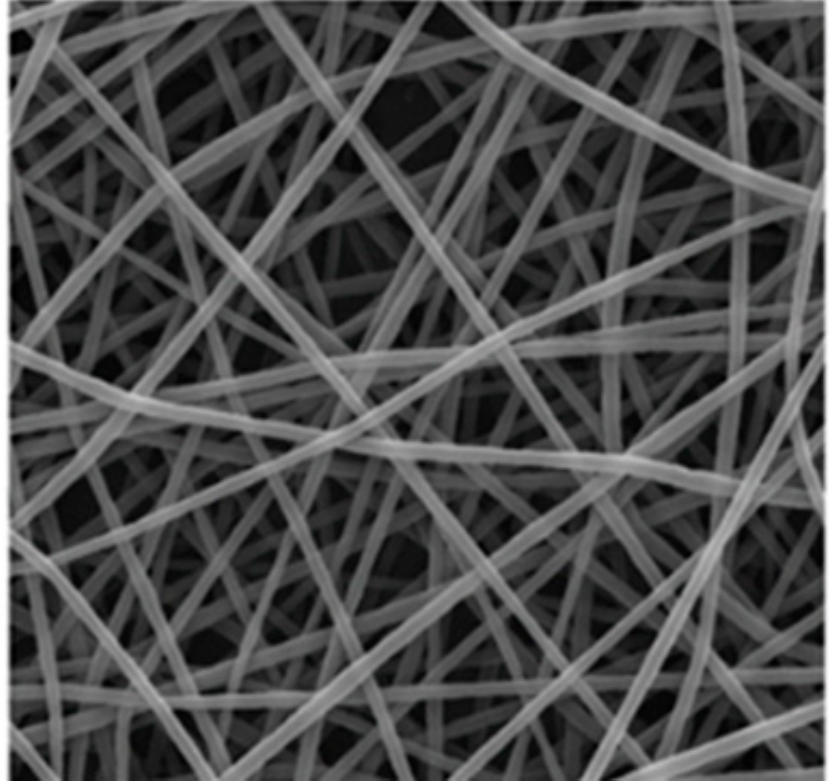
Figure 1. SEM image of polyimide nanofibers structure. Fiber diameter: 0.234 ± 0.190 µm. contact angle 59.5 ± 6.30°.